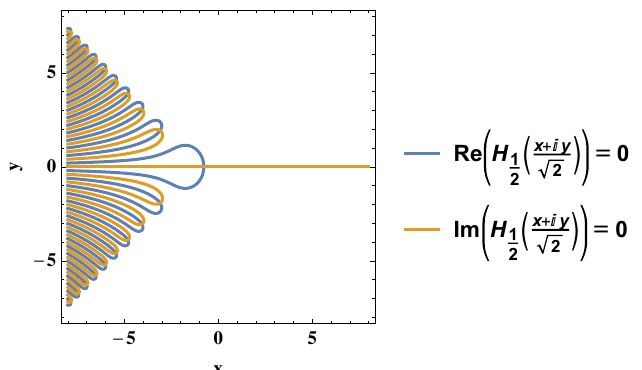
(cid:16) (cid:17) z p 2 2